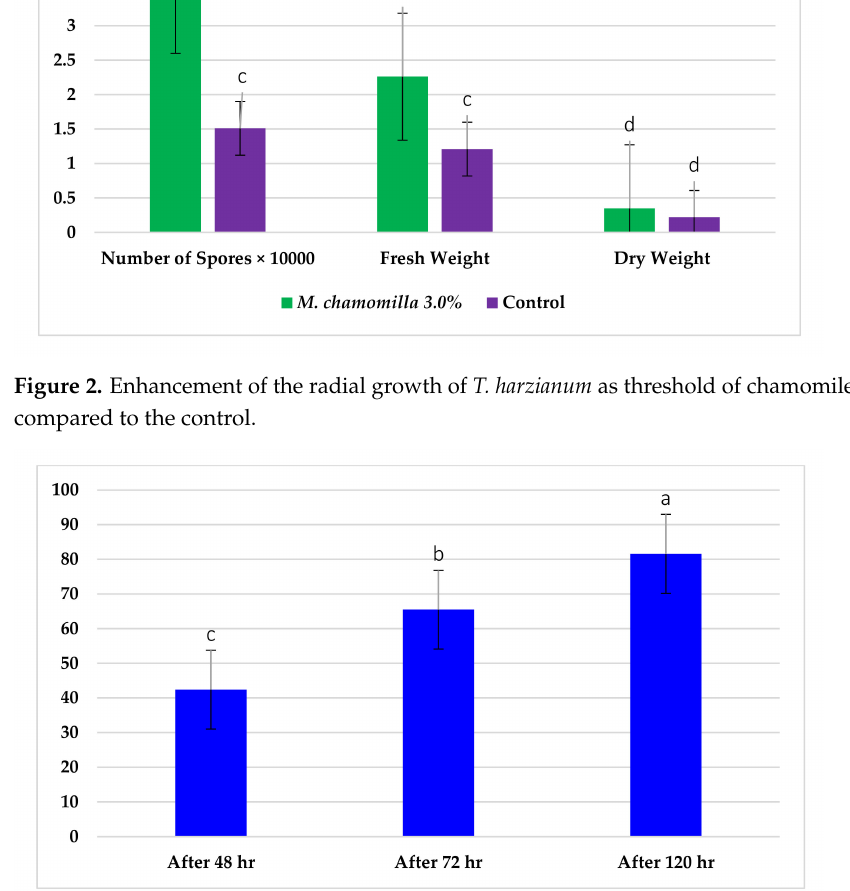
Figure 3. Growth reduction percentage of P. ultimum as antibiosis of T. harzianum